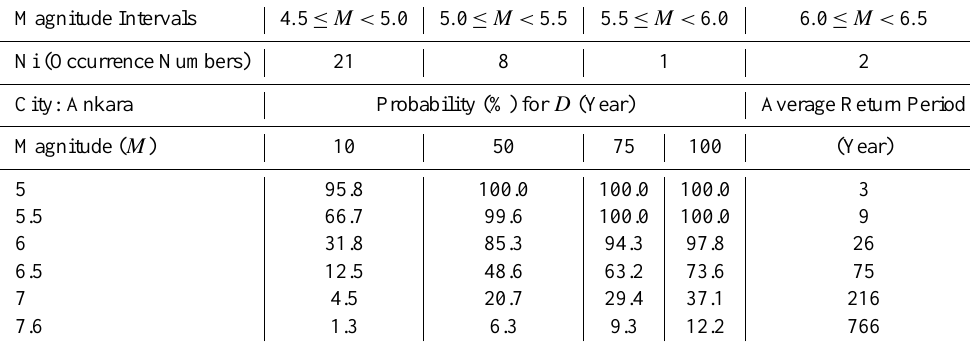
Table 3b. Earthquake occurrence probability (%) for D (Year) for. Ankara